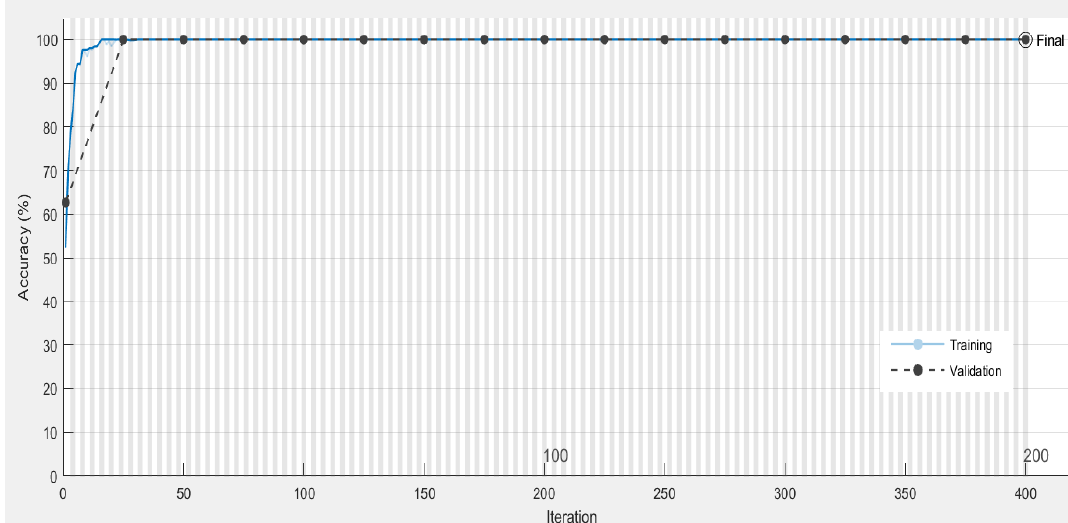
Figure 10. Plots of accuracy versus the number of iterations obtained using the LSTM classifier with hold-out CV for the automated classification of the BFMAC vs. DMAC tasks.